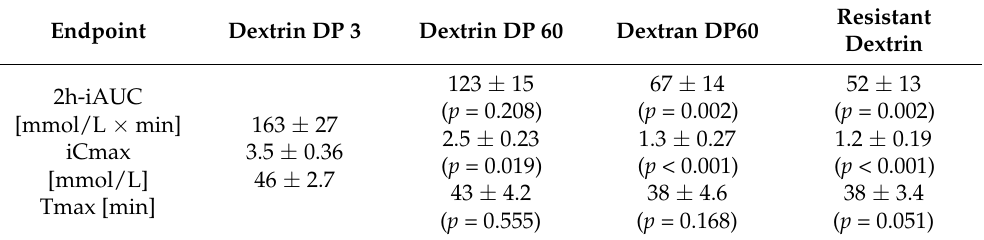
Table 3. Descriptive statistics (Mean ± SE, N = 10) for the four products featuring 25 g powder dissolved in 300 mL water. For pairwise comparisons vs. Dextrin DP 3 (paired t -test, two-sided), p -values are given in